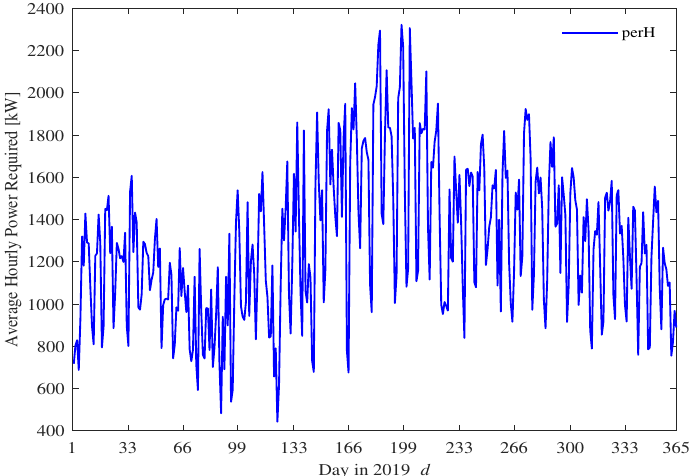
Figure 5. Average power required per hour per